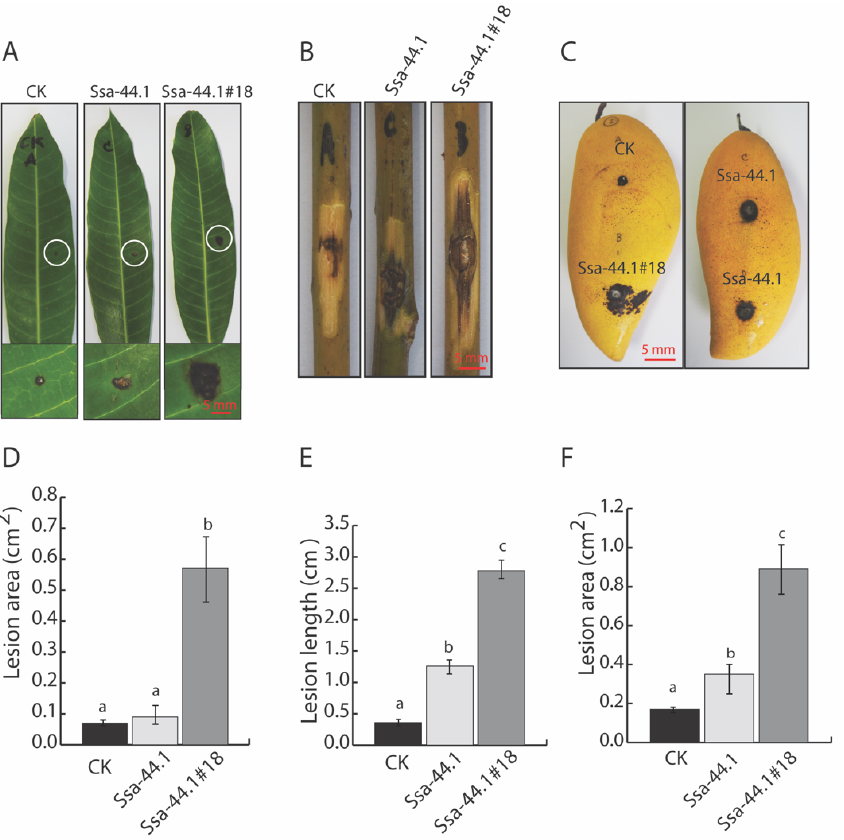
Figure 5. Virulence assay of virus-infected and virus-free C. gloeosporioides on mango. ( A ) The images illustrate representative lesions elicited by the fungal strains 7 days after mango leaf inoculation. A white circle was used to represent the symptom zones, which were enlarged at the bottom of each leaf image. ( B ) The images illustrate representative lesions elicited by the fungal strains 7 days after mango twig inoculation. ( C ) The images illustrate representative lesions elicited by the fungal strains 10 days after mango fruit inoculation. ( D ) Graphical representation of lesion areas on mango leaves measured as described in ( A ). ( E ) Graphic representation of lesion lengths on mango twigs measured as described in ( B ). ( F ) Graphic representation of lesion areas on mango fruits meas- ured as described in ( C ). The data from 5 replicates are means ± SD with different letters that are significantly different ( p < 0.05) among treatments using one-way ANOVA analysis. The control variable (CK) was inoculated with PDA (agar plugs) only.